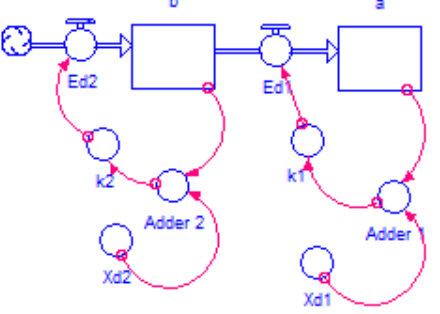
Figure 9. Forrester diagram for the basting process with two state variables.